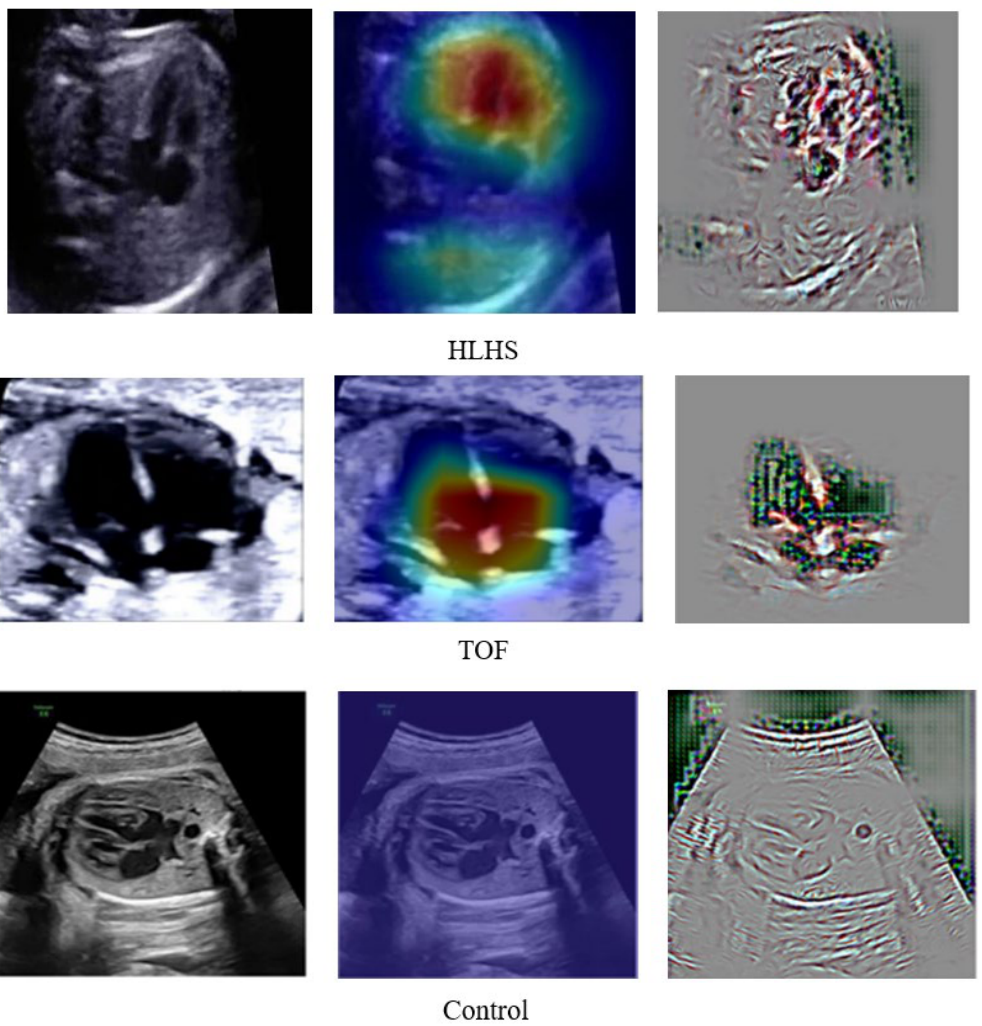
Figure 8. DenseNet201 Classification Result Explained by Guided–BP and Grad–CAM.